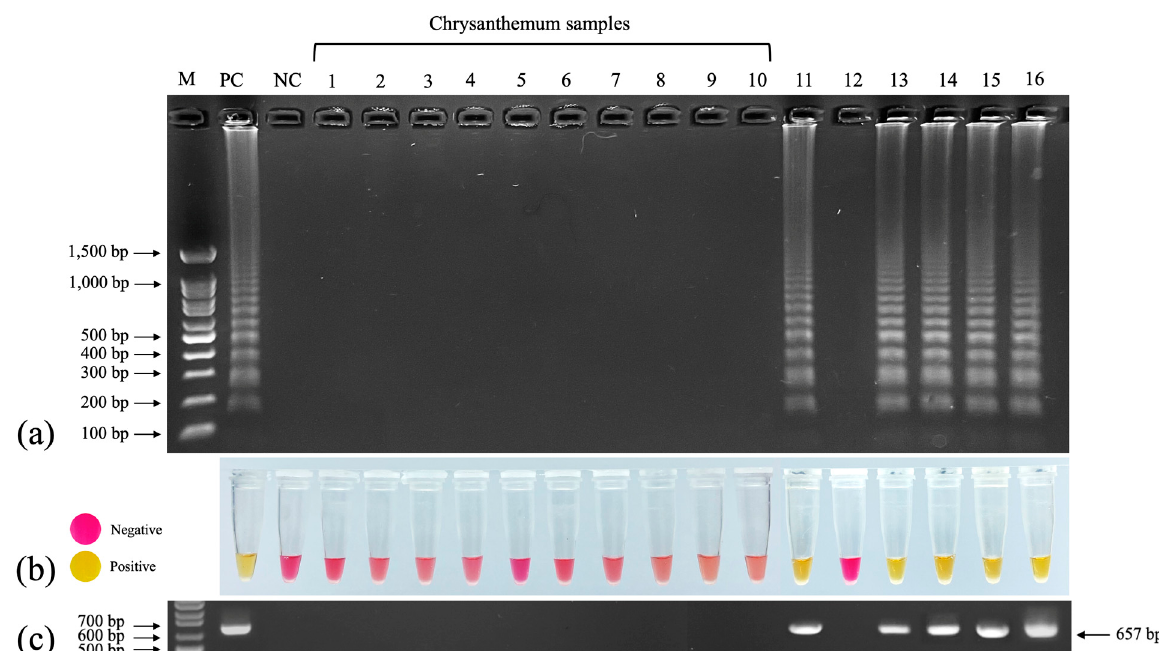
Figure 7. Detection of TMV in plant samples using colorimetric RT–LAMP. Lanes 1–10: chrysanthemum samples from 6 cultivars; lane 11: chrysanthemum inoculated with TMV; lane 12: TMV-inoculated Cassia siamea ; lane 13: TMV-inoculated Capsicum annum ; lane 14: TMV-inoculated Nicotiana tabacum cv. Xanthi ; lane 15: TMV-inoculated Petunia x hybrida ; lane 16: TMV-inoculated Solanum lycopersicum . ( a ) RT–LAMP–AGE. ( b ) Colorimetric RT–LAMP. ( c ) RT–PCR with 657 bp amplicons of TMV CP gene. M: 100 bp + 1.5 kb DNA ladder (SibEnzyme, Novosibirsk, Russia); NC: